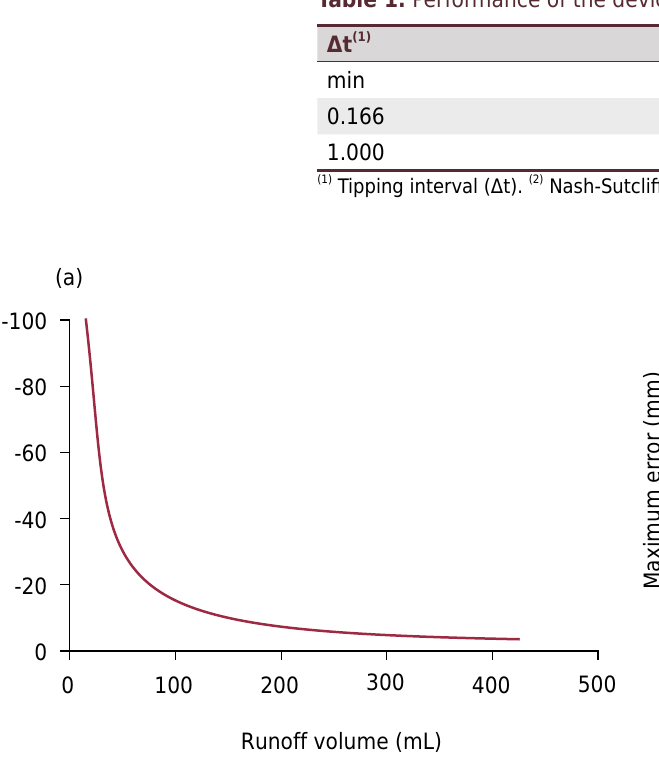
Figure 5. Maximum resolution error by runoff volume (a) and plot area (b). Negative values indicate underestimation of flow